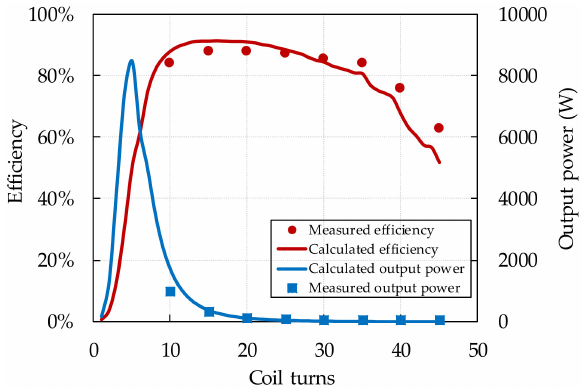
Figure 14. Relationship between coil turns and system performance with fixed inner and outer radius.